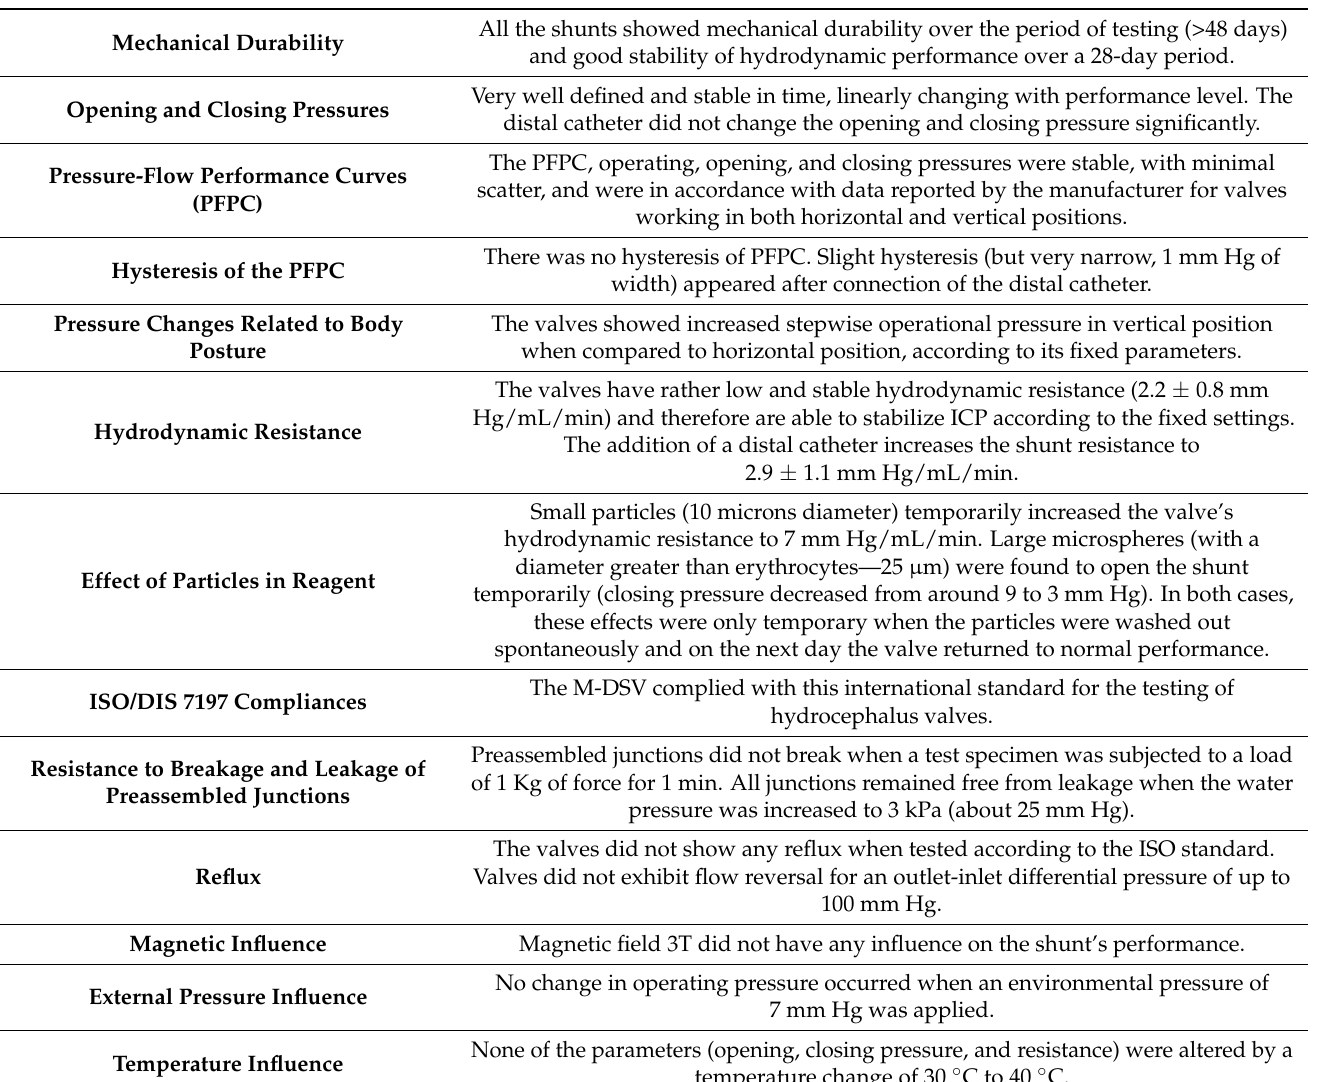
Table 2. Evaluation of the performance and hydrodynamic properties of Miethke ® Dual-Switch valves (M-DSV) by the U.K. Shunt Evaluation